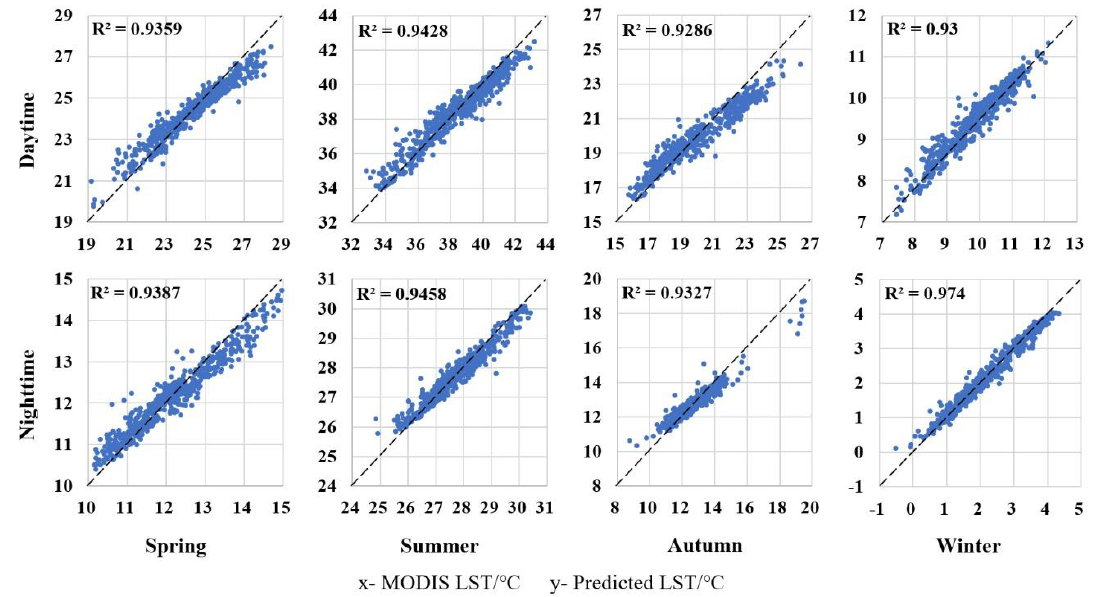
Figure 10. Scatter diagrams of predicted LST data based on the RF models ( y -axis) versus MODIS LST data ( x -axis). (The black dashed lines represent the 1:1 line; that is, the predicated LST and MODIS LST of the scattered points falling on this line are equal).